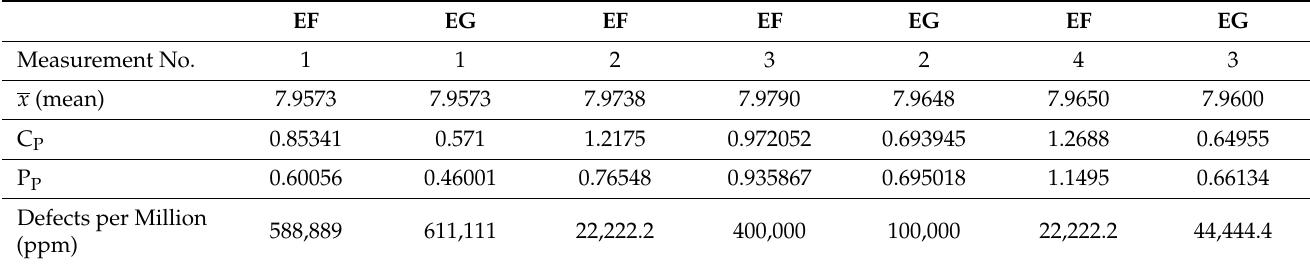
Table 15. Mean, C P , P P and the proportion of defective shafts in repeated measurements of pairs EF and